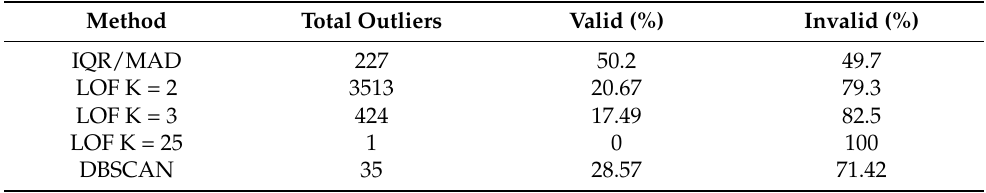
Table 4. Number of valid/invalid outliers detected using the implemented scoring method for Faculty of Building Services